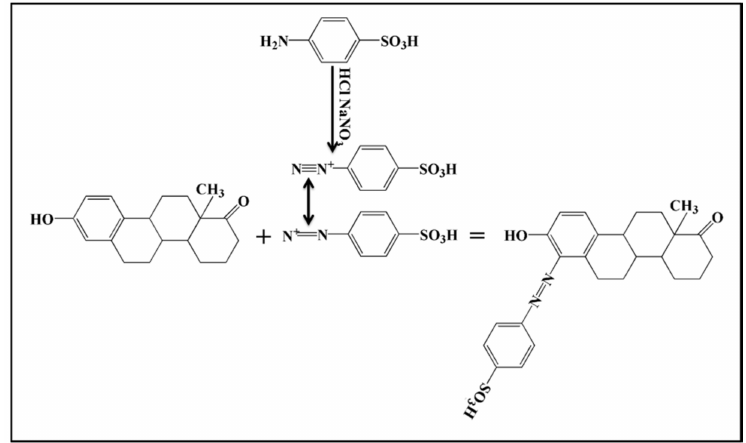
Figure 3. Coupling reaction between estrone (E1) and diazonium